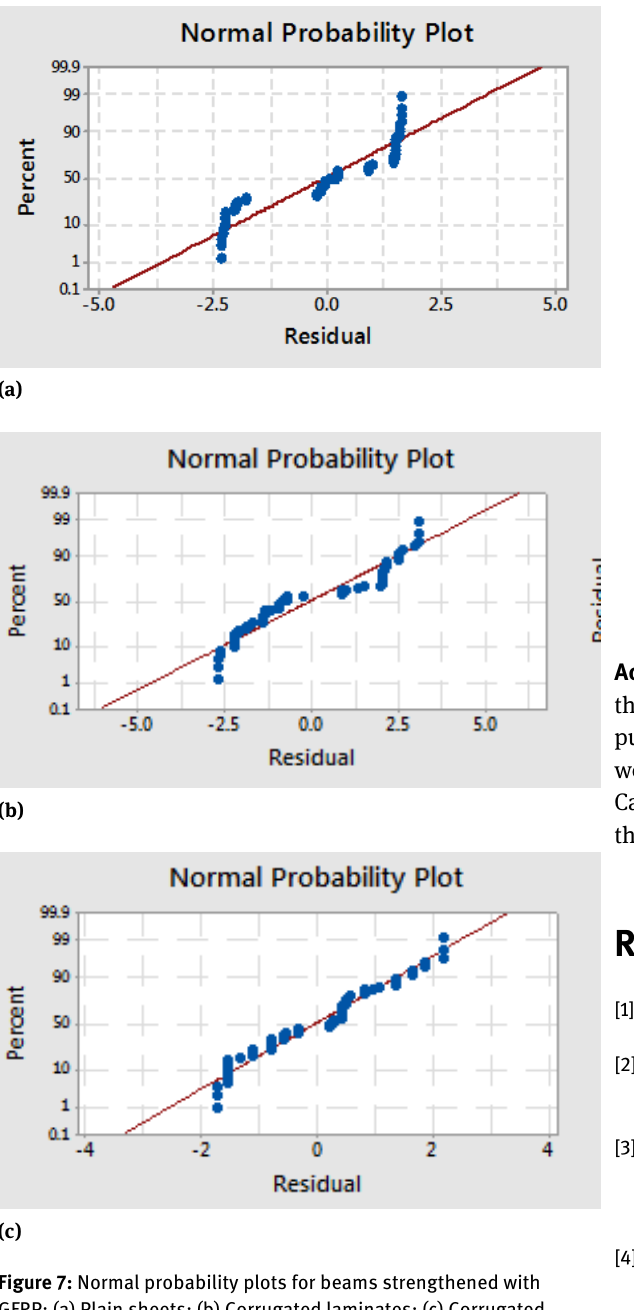
Figure 7: Normal probability plots for beams strengthened with GFRP: (a) Plain sheets; (b) Corrugated laminates; (c) Corrugated laminates and mechanical